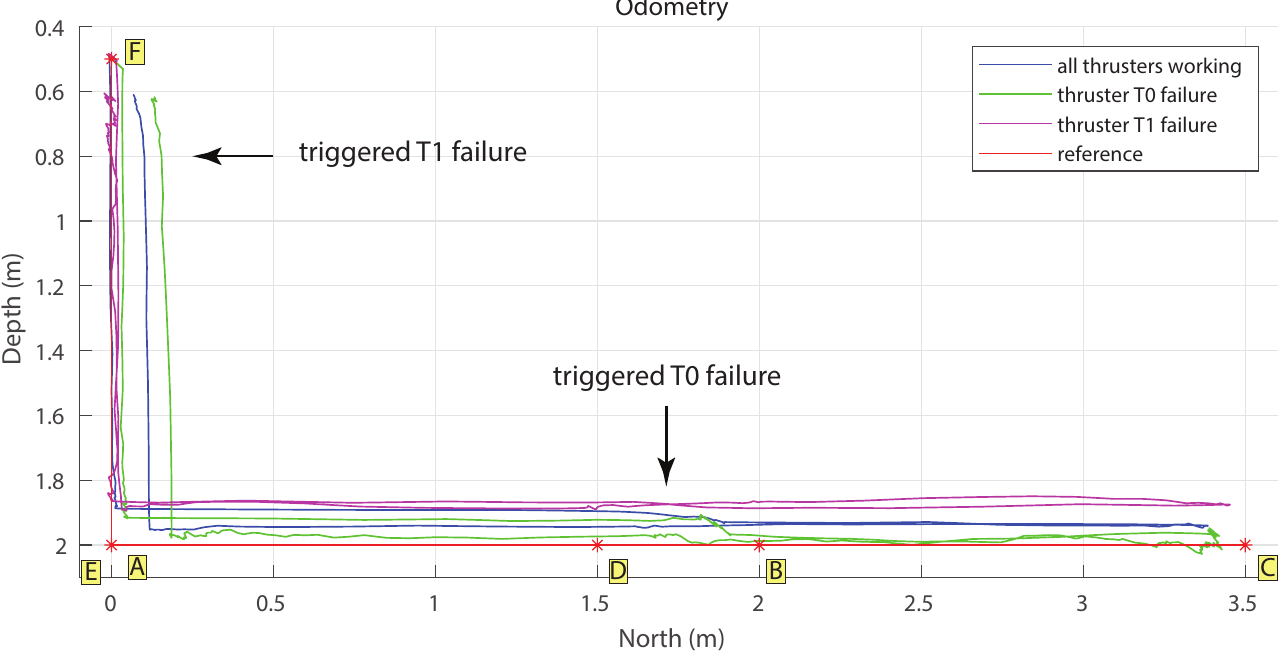
Figure 9. Odometry measurements during the thruster failure experiments. Yellow squares depict the reference